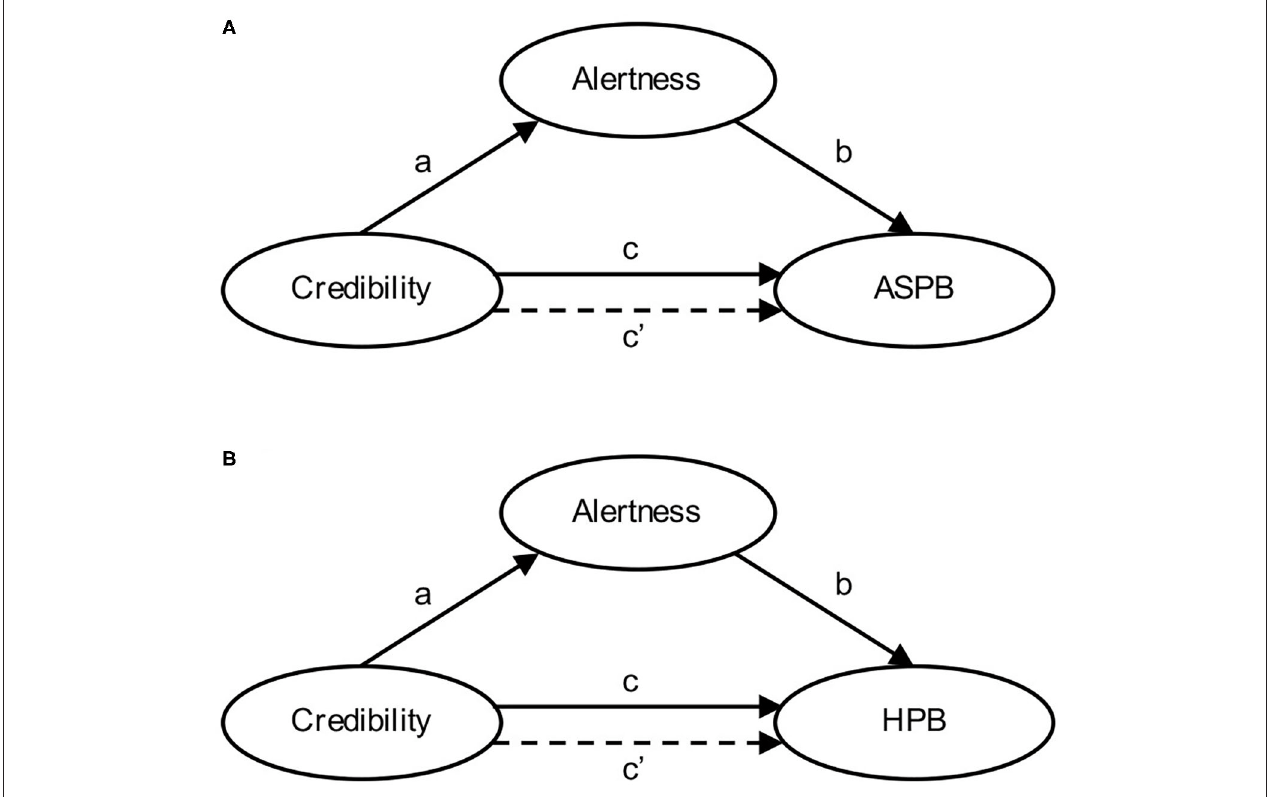
FIGURE 5 | Proposed mediation models for predicting engagement in actual self-protective behavior (ASPB) and hypothetical protective behavior